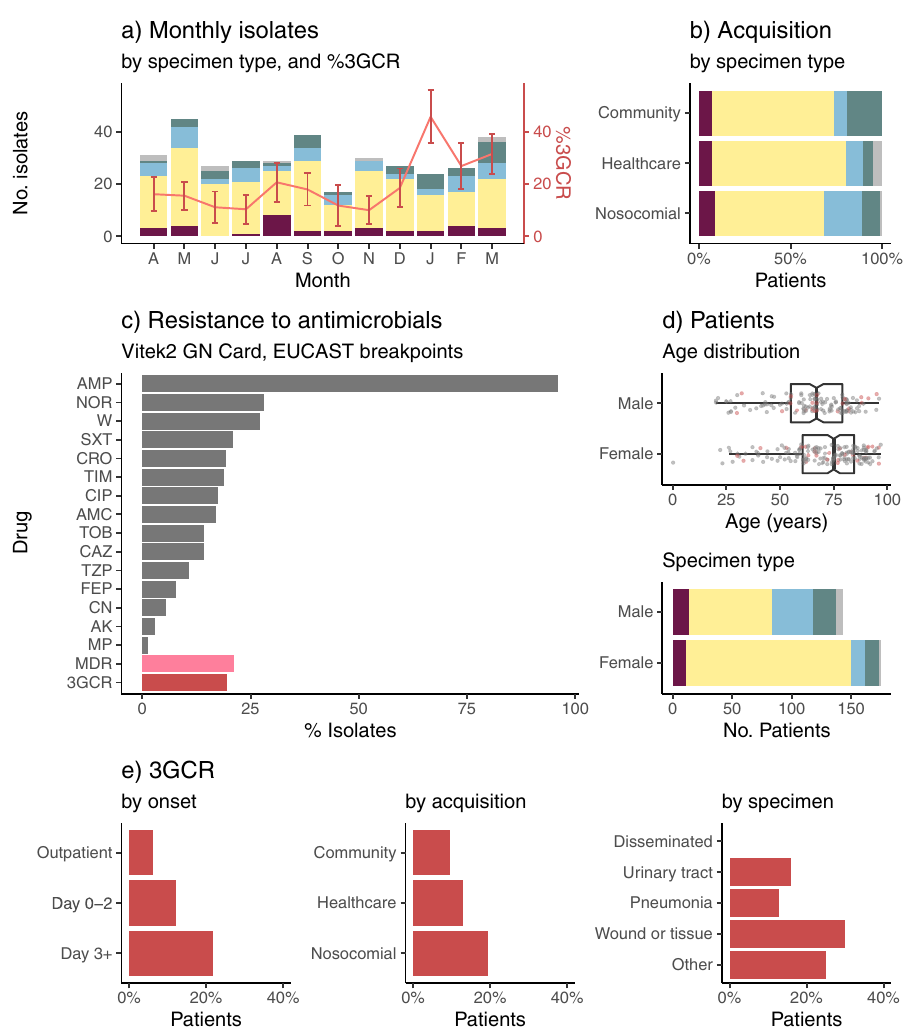
Fig. 1 Characteristics of clinical isolates identi fi ed as K. pneumoniae in the hospital microbiological diagnostic laboratory. a Monthly isolate counts (total 362 isolates, from 318 patients), coloured by specimen type (maroon = disseminated, yellow = urine, blue = respiratory, green = wound, grey = other). Red line shows frequency of 3 rd generation cephalosporin resistant (3GCR) isolates per month, according to the right-hand y-axis (central point indicates frequency, error bars indicate standard error). b Specimen types (coloured as per panel a) according to inferred mode of acquisition of infection (inferred from hospital contact in past 30 days (nosocomial) or past year (healthcare associated), see Methods). c Bars show proportion of isolates resistant to each drug (AK, amikacin; AMC, amoxicillin – clavulanic acid; AMP, ampicillin; CAZ, ceftazidime; CIP, cipro fl oxacin; CRO, ceftriaxone; FEP, cefepime; CN, gentamicin; MP, meropenem; NOR, nor fl oxacin; SXT, trimethoprim-sulfamethoxazole; TIM, ticarcillin – clavulanic acid; W, trimethoprim; d Characteristics of patients ( n = 318) from whom K. pneumoniae was isolated. Age distribution: points indicate individual patients (those with ≥ 1 3GCR isolate are coloured red). Boxplot elements are: center line, median; box limits, upper and lower quartiles; whiskers, 1.5x interquartile range; points, all individual patients. Specimen type: stacked bars are coloured as per panel a to indicate the fi rst specimen type, for each patient, from which K.